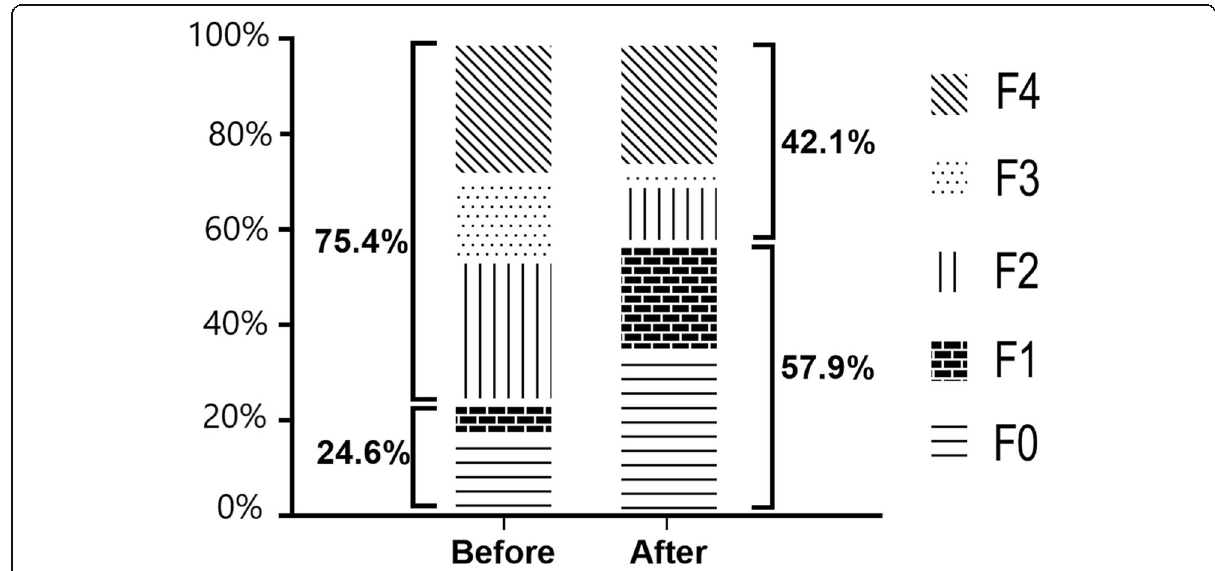
Fig. 1 Relation between fibrosis stage before and 72 weeks after SMV/SOF therapy